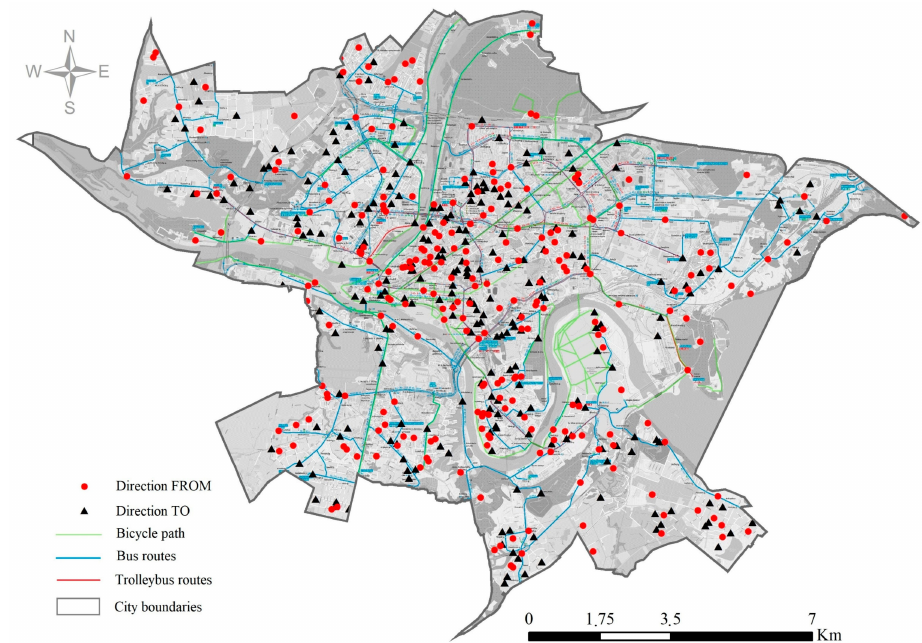
Figure 1. Kaunas city street, PT and bicycle path network and commuting patterns (origin and destination locations) of the study